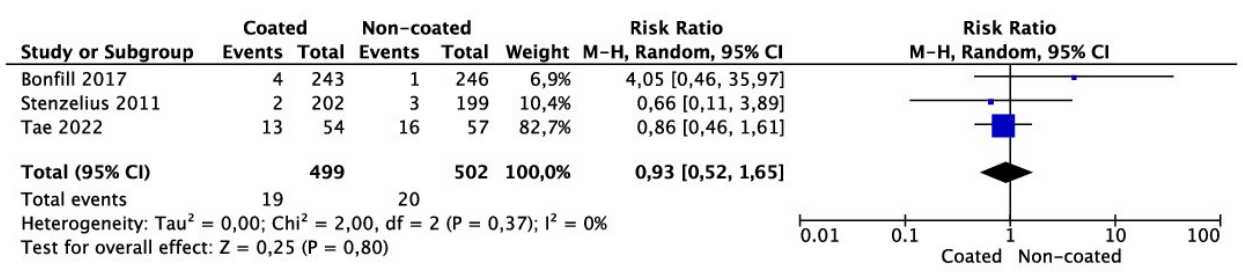
Figure 5. Meta-analysis of the number of patients reporting lower urinary tract symptoms at follow- up after removal of catheter.